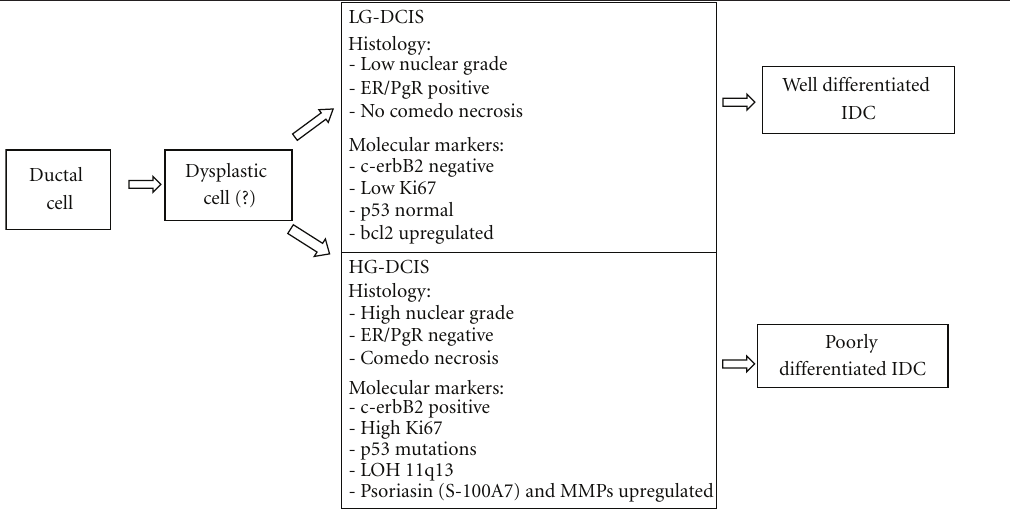
Table 4: Classification of DCIS based on biologic potential